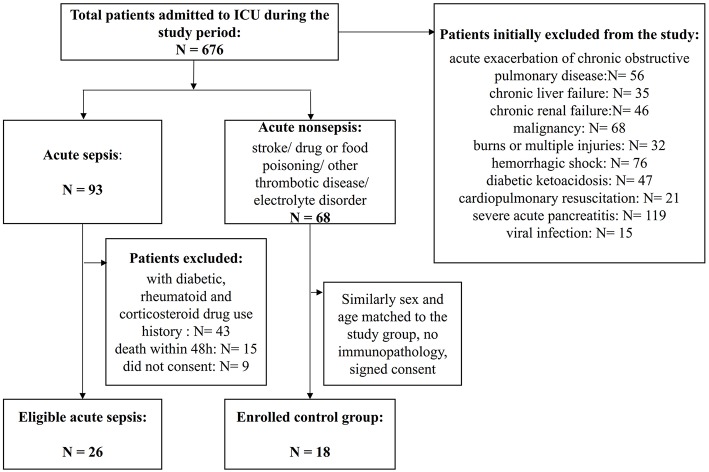
Flowchart of patient enrollment. A total of 676 patients were admitted to the ICU during the study period, and among them, 422 patients were identified as having severe infection. However, many patients had associated chronic immunocompromising diseases or drug use or acute exacerbations of chronic infections and needed to be excluded. Finally, 26 patients with sepsis were enrolled, and 18 patients with similar critical scores that were sex- and age-matched non-septic patients were enrolled as the controls.